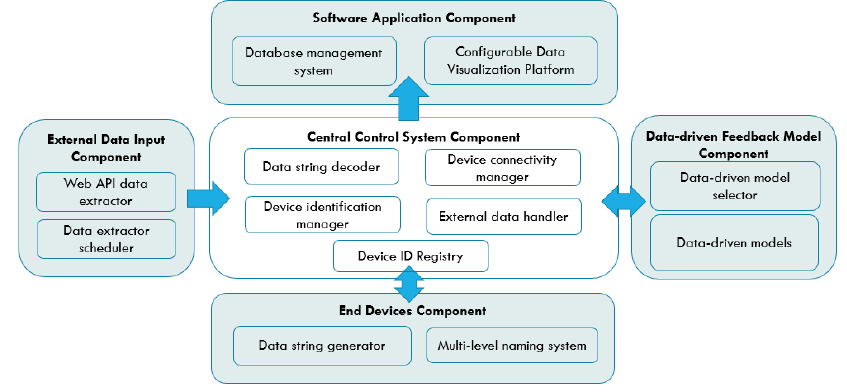
Figure 1. The components of the proposed IoT